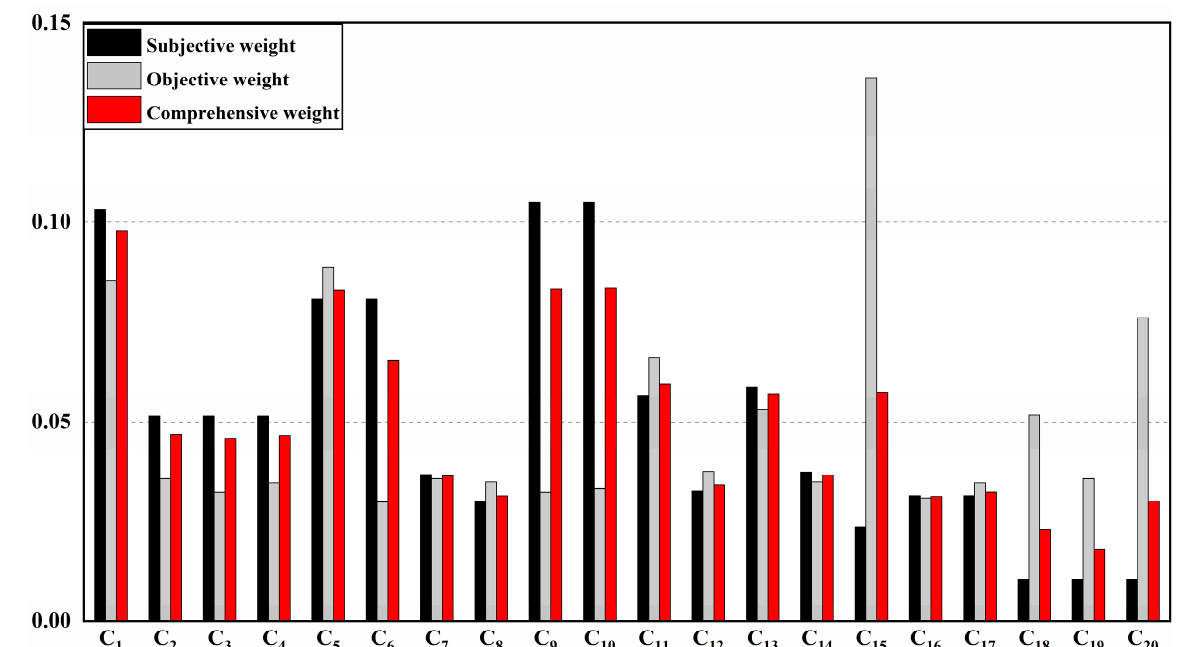
Figure 4. Comparison Chart of Secondary Indicator Weights.